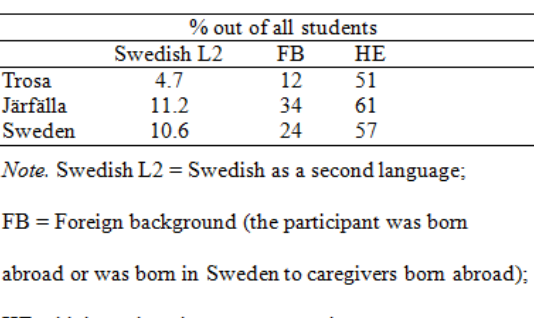
Table 3 indicates results from the reading subtests in the municipalities involved in this study, as well as the national average, in order to provide an overview of the relative educational attainment within the sam- ple (downloadable information in English about the national test is available on the Swedish